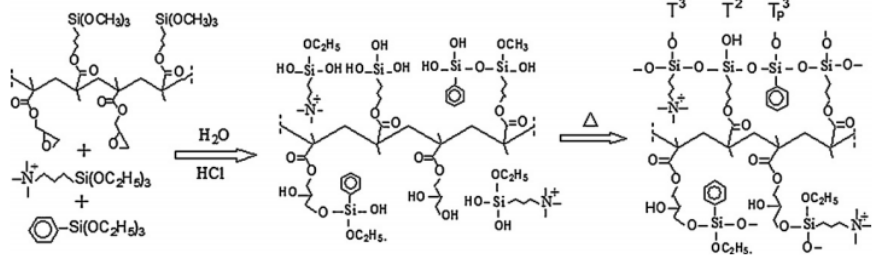
Figure 1. Schematic synthesis of AEM showing the role of glycidyl and alkoxysilane groups. Reprinted from Reference [47] with permission from Elsevier.